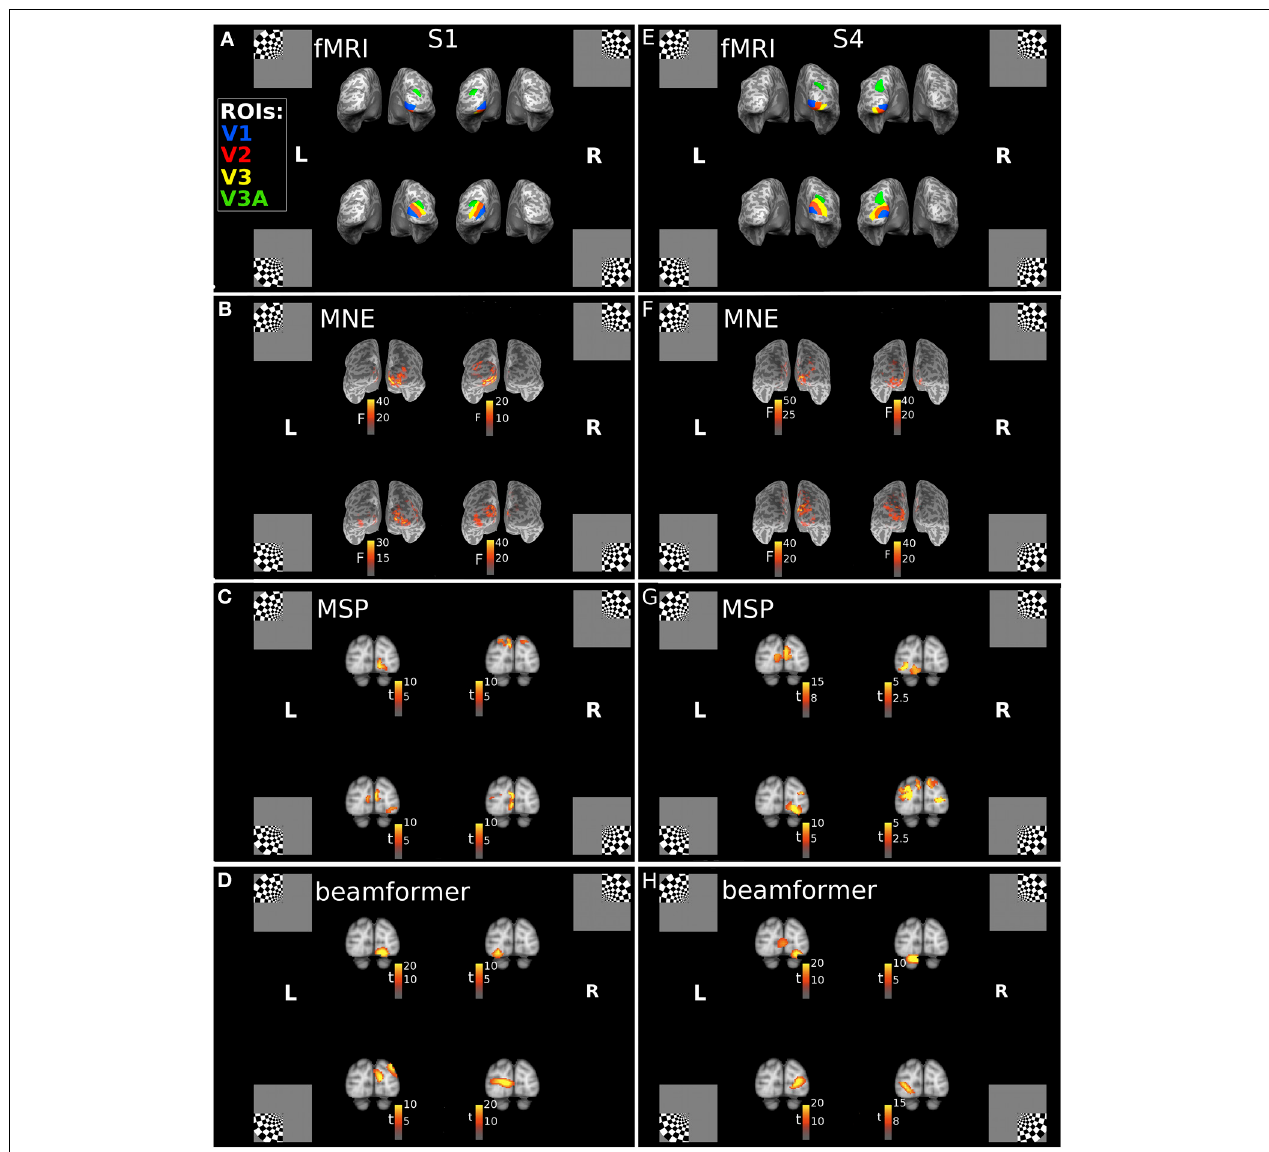
FIGURE 2 | Locations of the fMRI- and MEG-measured brain responses to quadrant stimuli. (A,E) Individual fMRI-defined ventral and dorsal subregions of early visual areas, which respectively represent upper field and lower field quadrant stimuli, for Subject 1 (S1) and Subject 4 (S4). Blue = area V1; Red = area V2; Yellow = area V3; Green = area V3A. Insets indicate stimulus locations. (B–D) Retinotopic source reconstructions of MEG responses to quadrant stimuli around the first response peak (FRP) for Subject 1.